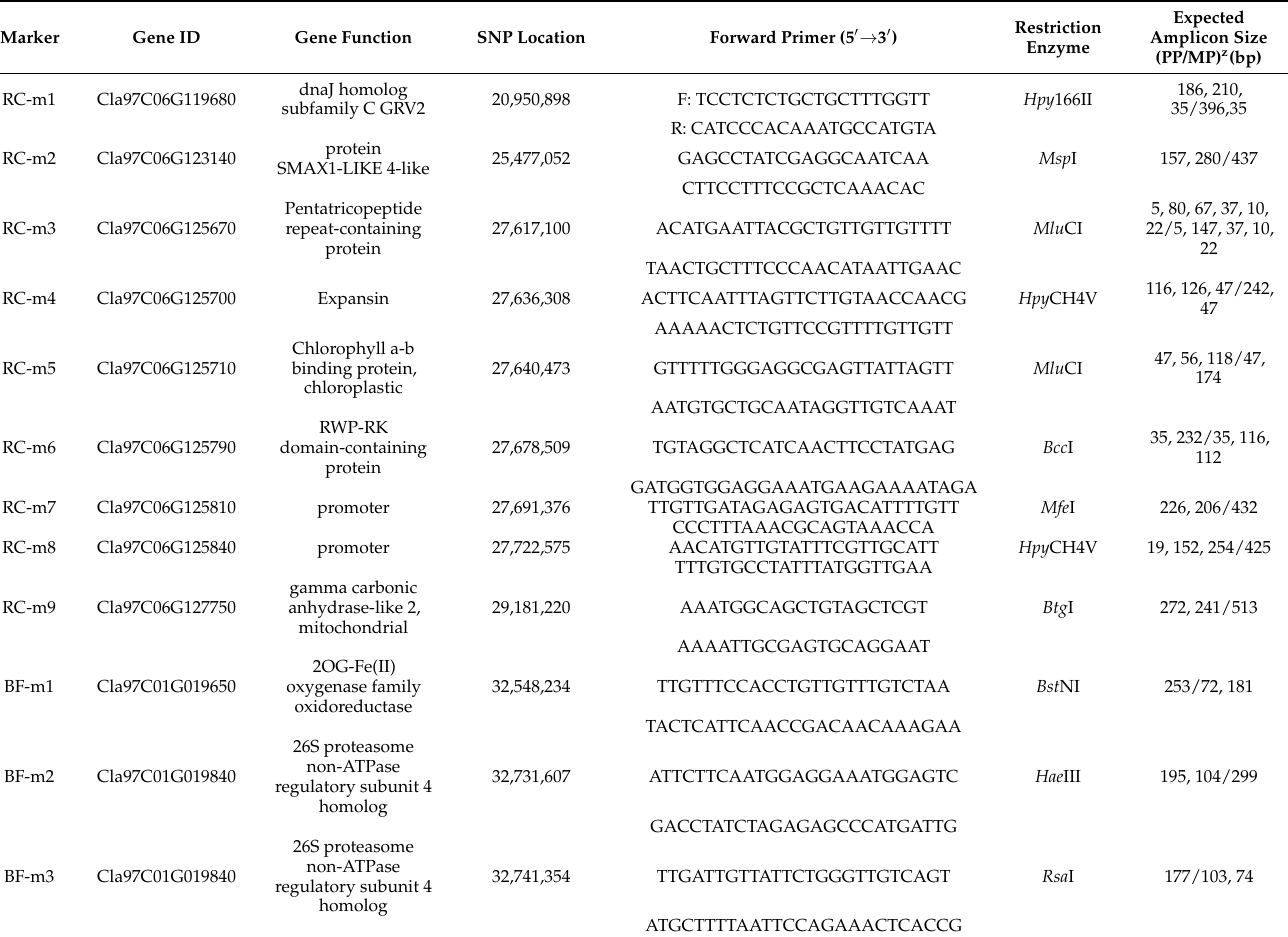
Table 2. List of cleaved amplified polymorphic sequence (CAPS) markers developed from single nucleotide polymorphisms (SNPs) located on RC-QTL-C6 and